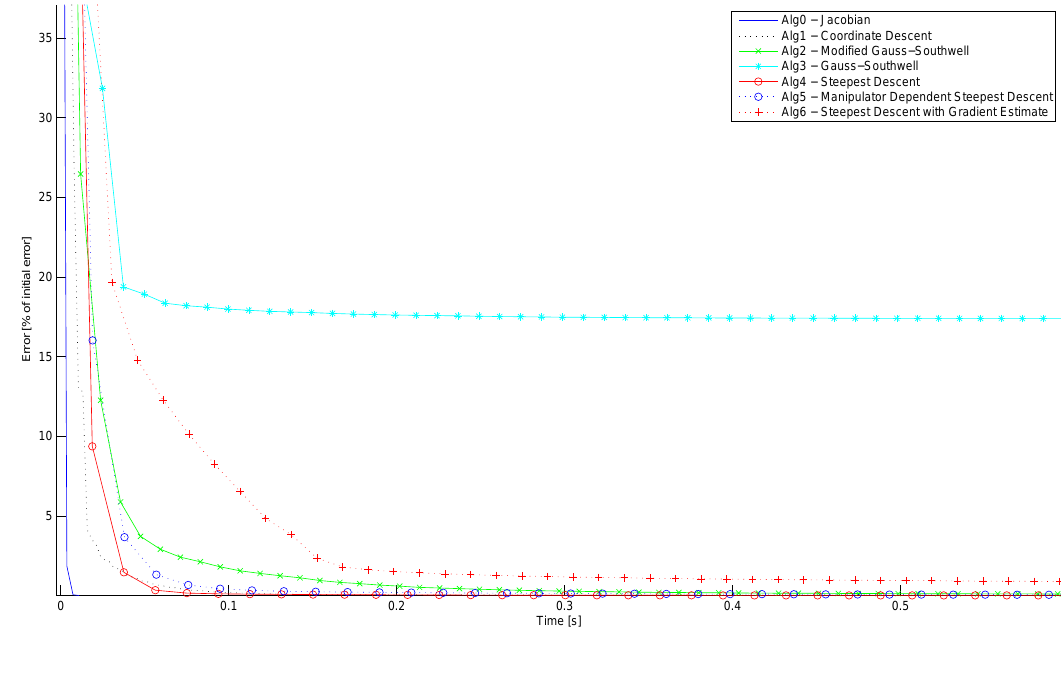
Figure 7: Convergence of algorithms with initial conditions close to solution with respect to